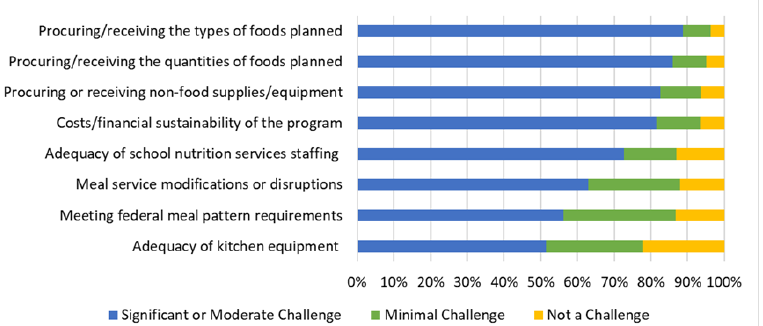
Figure 3. Challenges implementing universal school meals in the SY 2021 – 22, as per the Californian school food authorities ( n = 577 to 575 depending on missingness of responses). Stratified analyses showed there were no statistically significant differences in chal- lenges experienced by FRPM eligibility or urbanicity ( p > 0.05) (Table 4). SFAs with me- dium and large sizes perceived all the challenges as greater, compared with the percep- tions of smaller SFAs (<0.025), except for meeting federal meal pattern requirements, a difference that was greater for larger rather than smaller SFAs, but it was not statistically different between small and medium SFAs ( p- value for pairwise comparisons = 0.04 which is not smaller than the Bonferroni corrected value of 0.025). Table 4. Frequency of challenges with regard to school meals experienced in the SY 2021 – 22, using select SFA characteristics noted by the Californian school food authorities ( n = 581) 1 .